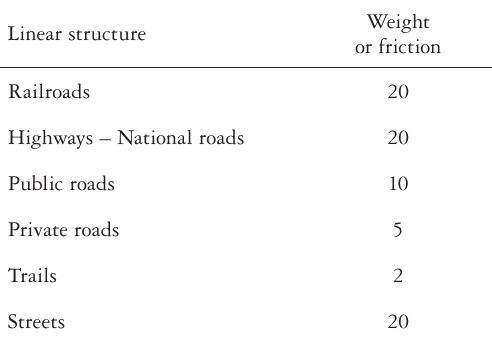
Table 4. Weights used for weighting linear structures in the fragmentation indices and as friction values in the reachability